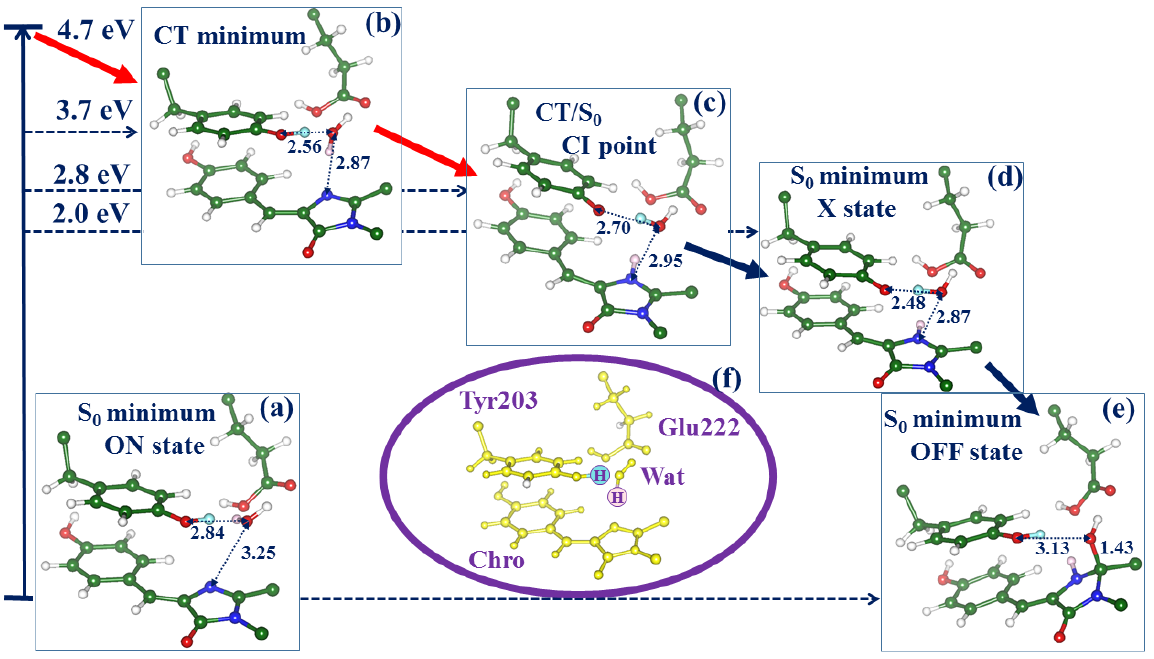
Figure 4. Mechanism of the ON – OFF light-induced reaction in the chromophore-containing pocket in Dreiklang by the results of the SA2-CASSCF calculations. Panels ( a – e ) show the chromophore, the side chains of Tyr203 and Glu222 and the water molecule Wat along the reaction pathway. The shuttling protons from Tyr203 and Wat are distinguished by cyan and pink colors, as clarified in panel ( f ). The interatomic distances are given in Å.